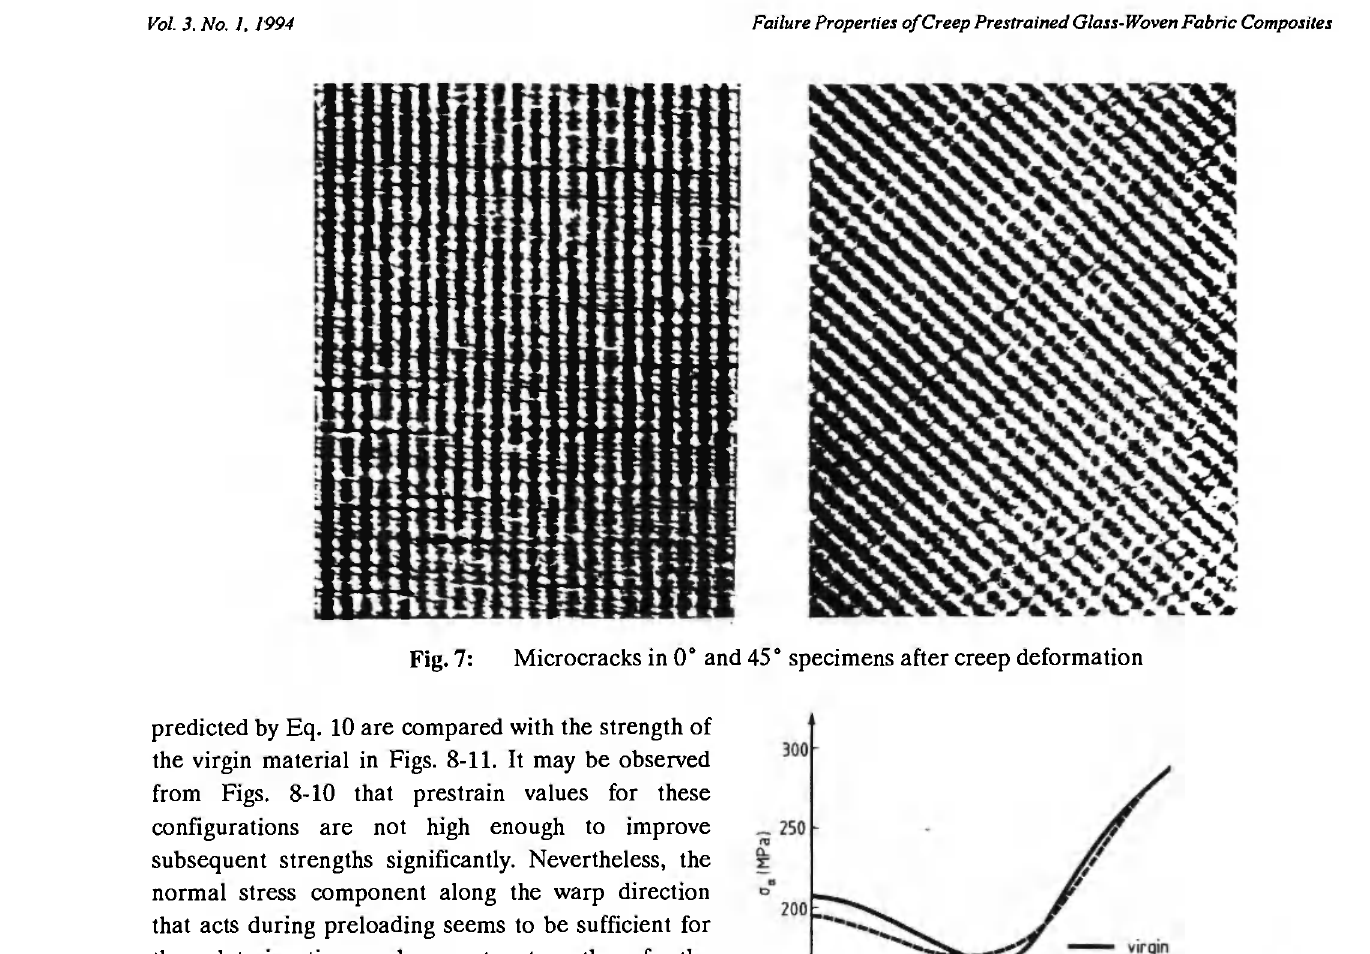
Fig. 8: Strength alteration due to prior creep in 75° direction